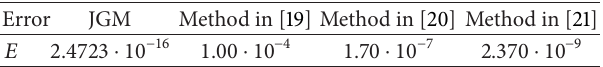
Table 2: Comparison between the best errors of different